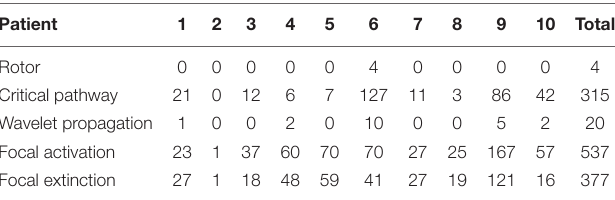
TABLE 3 | Frequency of left atrial activation events during lesion-by-lesion visual assessment of isopotential maps within each